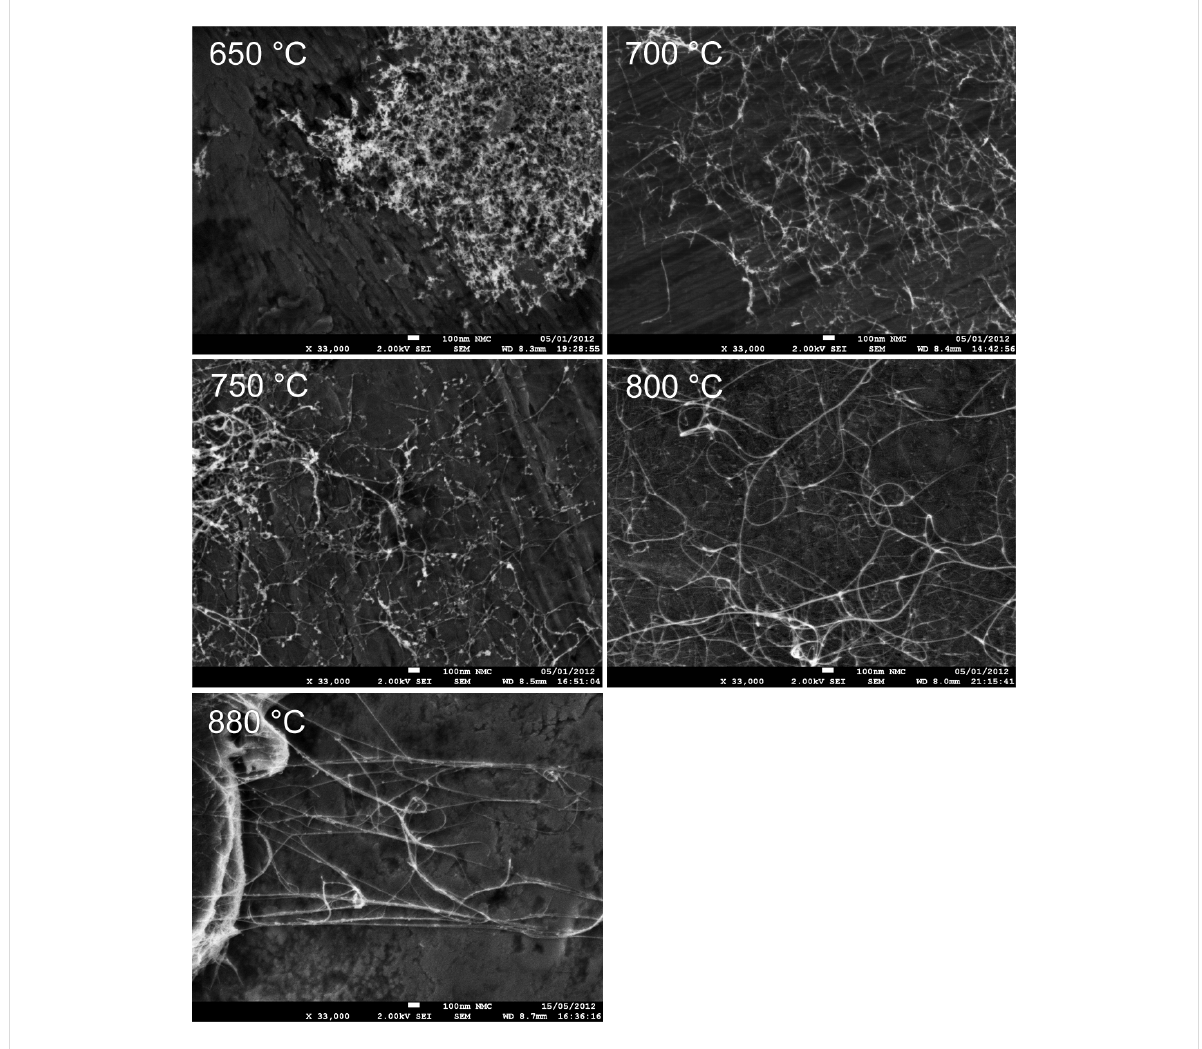
Figure 1: SEM images of as-prepared SWCNT networks dry-transferred onto the aluminium substrate. From top left, synthesis temperature increases from 650 to 880 °C and the average bundle length from 0.17 ± 0.01 to 9.80 ± 3.40 µm.